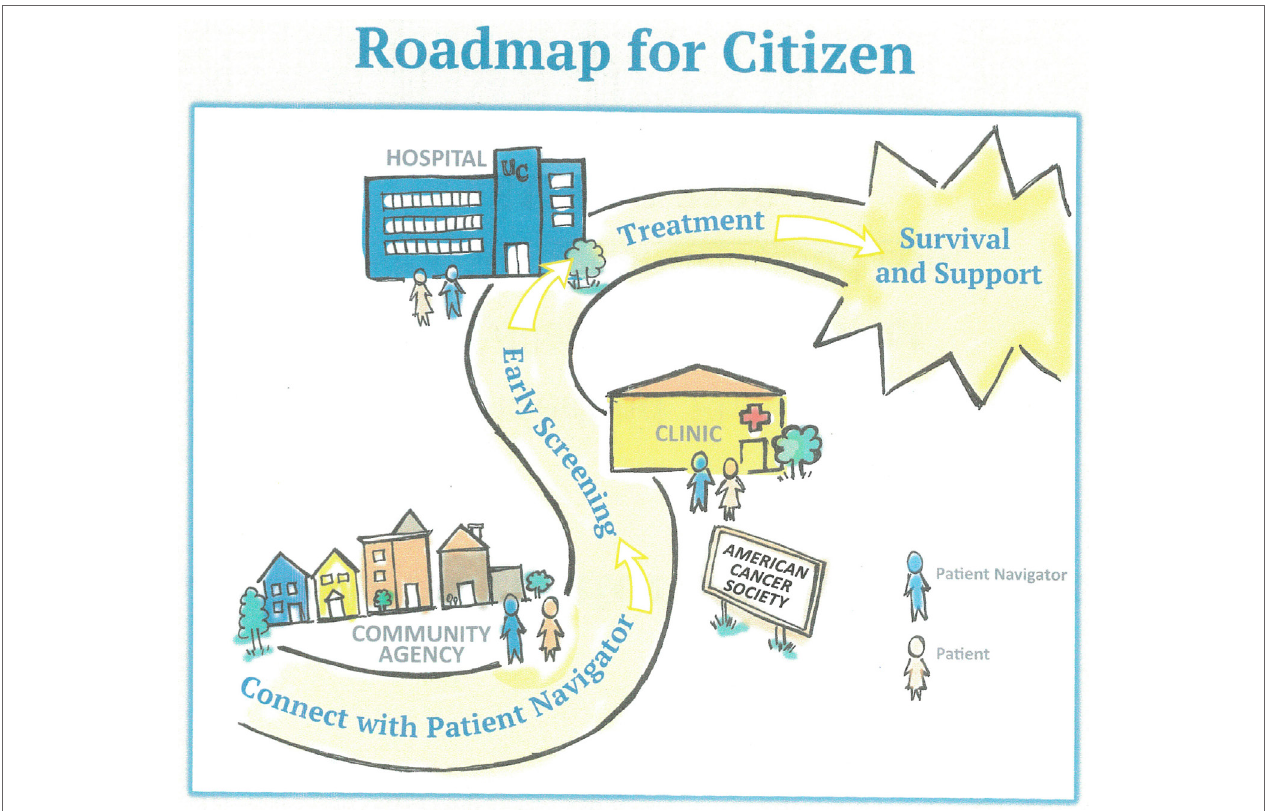
FigUre 1 | Sample material from CJN training packet promoting early